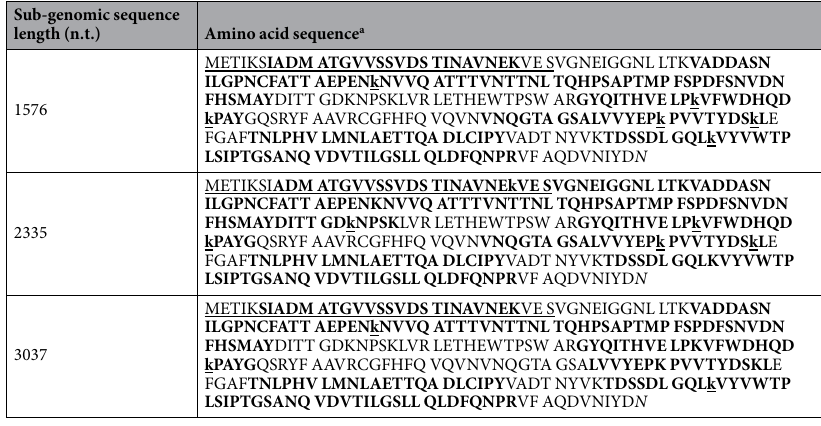
Table 3. Summary of peptides derived from capsid protein VP0 that were crosslinked to sub-genomic HPeV1 RNA. a The RCAP peptides identified are in bold. The missed cleavages are shown lowercase and highlighted in bold-underline. The disordered regions not identified in the atomic model are